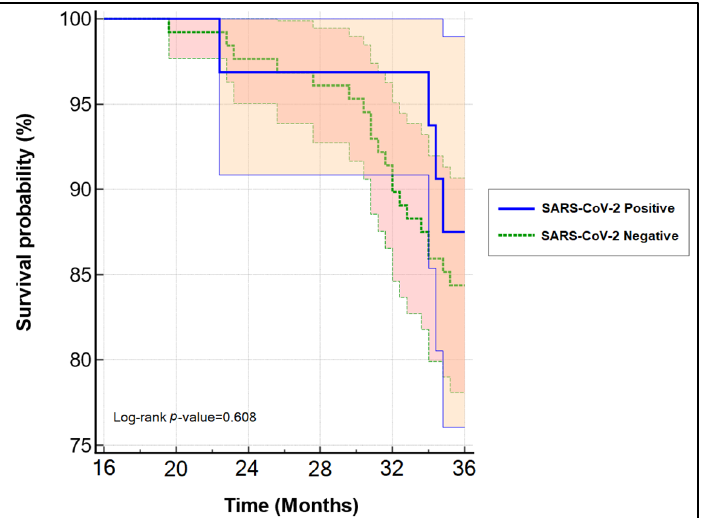
Figure 2. Kaplan–Meyer plot of the three-year survival probability in patients with newly-diagnosed cervical cancer based on SARS-CoV-2 infection status. Table 3. Multivariate regression analysis for the three-years mortality in patients with early-stage cervical